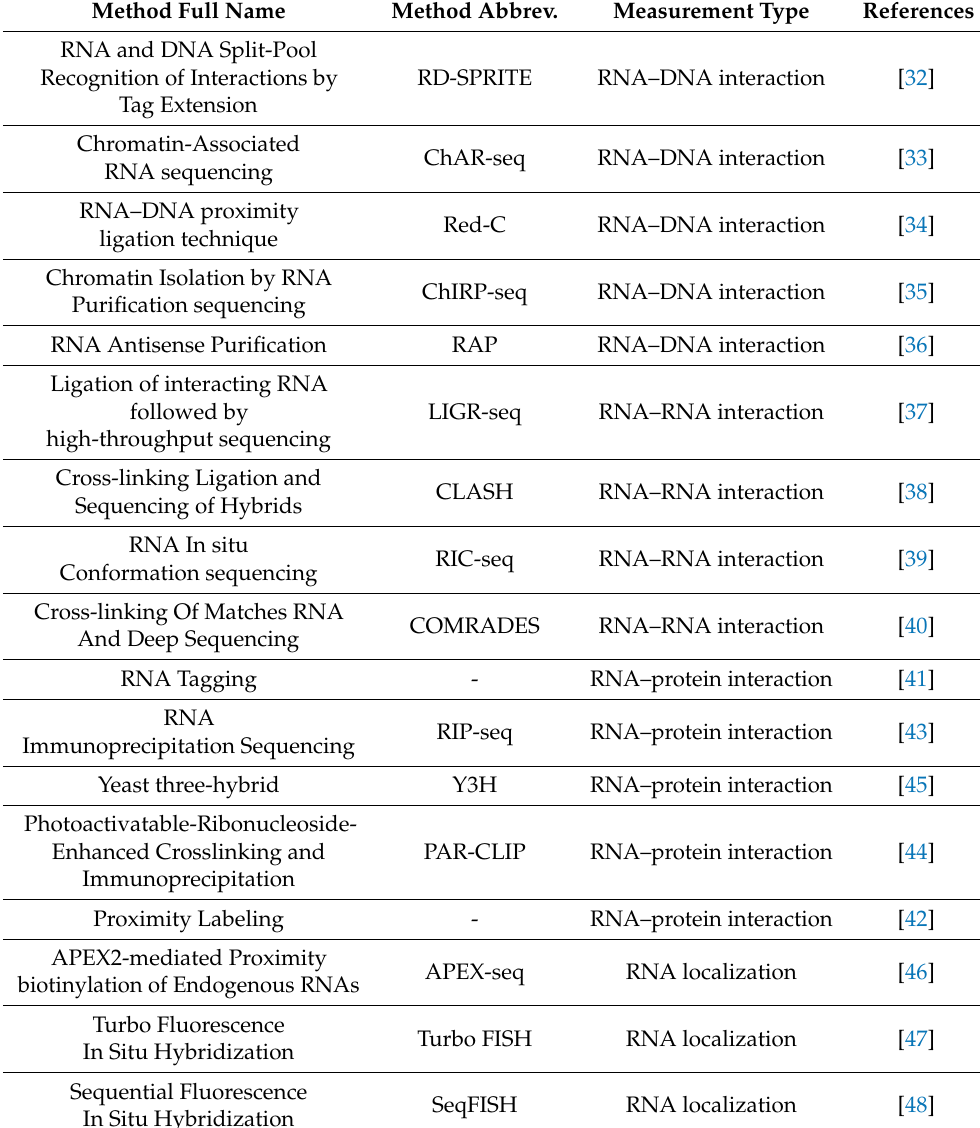
Table 1. Summary of representative methods to detect long noncoding RNA (lncRNA) interactions or